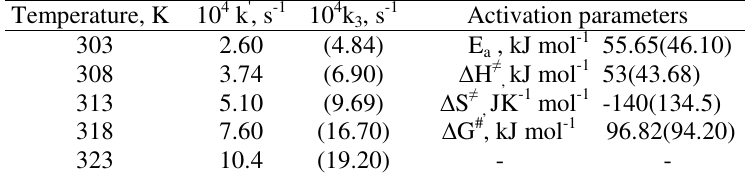
Table 3. Effect of temperature on the reaction rate and activation